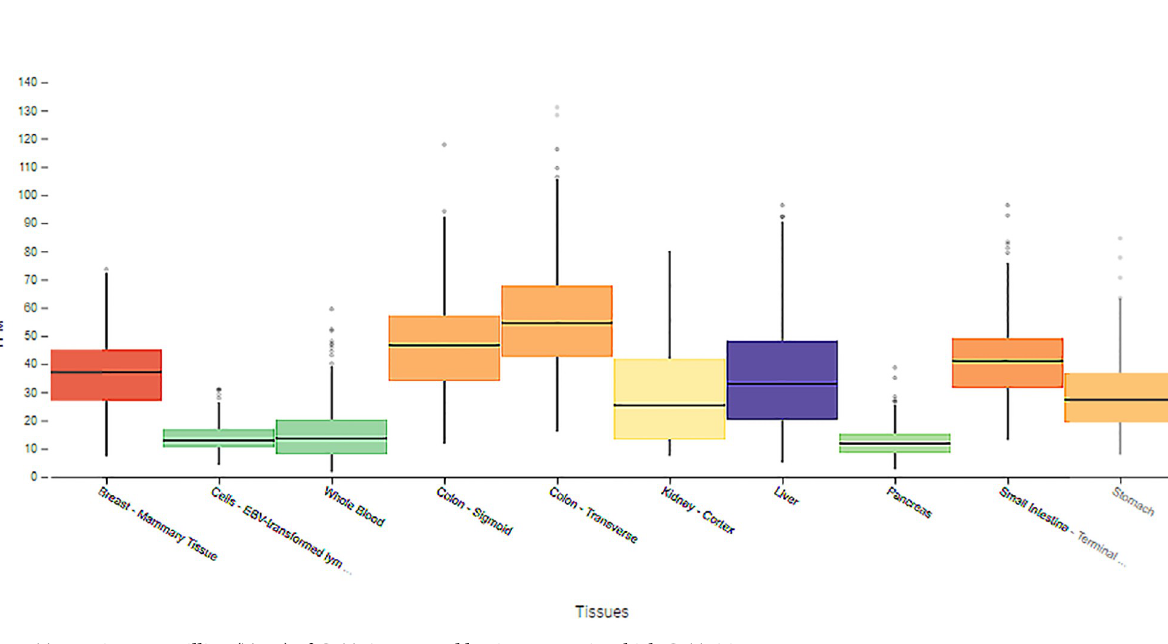
PLOS ONE | https://doi.org/10.1371/journal.pone.0281252 February 3,